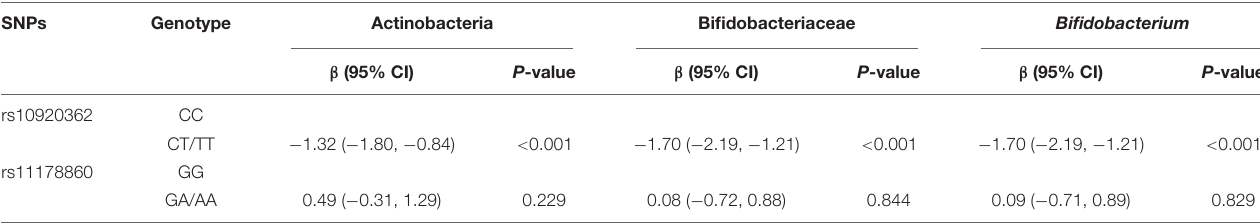
TABLE 6 | Results of generalized linear model analysis of the dependency of gut microbiota abundance on the two genetic